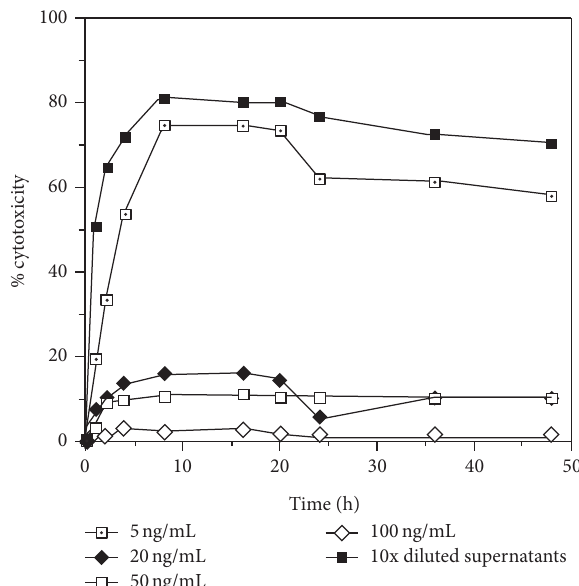
Figure 4: Neutralization curve of TNF- 𝛼 cytotoxicity in LPS-stimulated AMC supernatants by anti-TNF- 𝛼 monoclonal antibody. TNF- 𝛼 cytotoxicity in 10x diluted AMC supernatants containing final concentration of 5, 20, 50, or 100ng/mL anti-TNF- 𝛼 monoclonal antibody was assayed. Details were described in Materials and Methods.